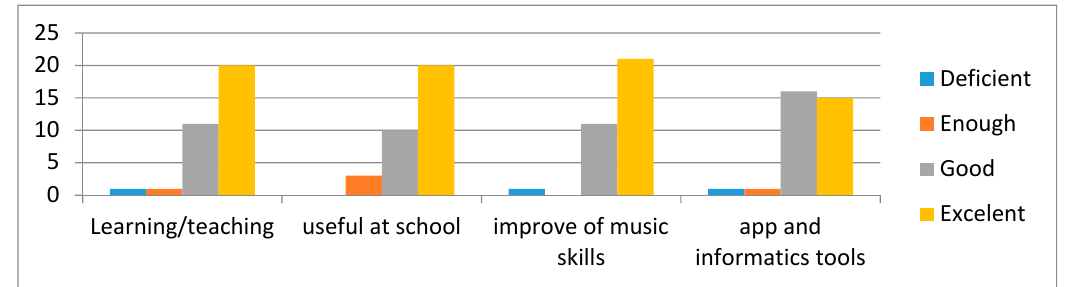
Figure 5. Perception with Leemusica/readmusic methodology at